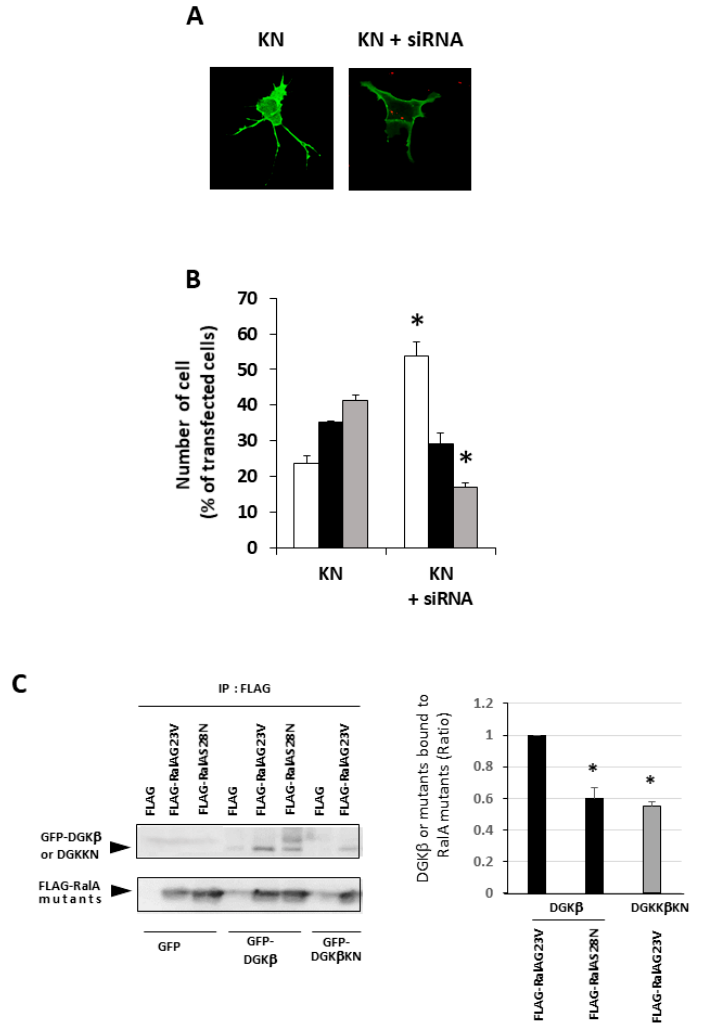
Figure 4. Importance of RalA in the DGK β KN-induced neurite outgrowth. ( A ) Typical image of SHSY-5Y overexpressing GFP-DGK β KN before and after treatment of siRNA for RalA. ( B ) Effect of siRNA for RalA on the number of cells having no (white column), one or two (black column) and several neurites (gray column). The plasmid of GFP-DGK β KN was transfected with or without 100 nM siRNA for RalA. More than 100 cells were observed in each experiment and three independent experiments were performed. The mean and SEM of the number of the cells are shown as percentage to the transfected cells. * p < 0.05, followed by Student’s t -test (vs. the control expressing GFP-DGK β KN). ( C ) Active form of RalA bound to both DGK β or DGK β KN. Pull down assay was performed using COS-7 cells separately overexpressing FLAG-RalA mutants and GFP-DGK β or GFP-DGK β KN. Three independent experiments were performed. The mean and SEM of density of bands are shown as ratio to the WT DGK β . * p < 0.05 followed by Student’s t -test (vs. GFP-DGK β ). It is well known that RalA binds to many proteins, including PLD and calmodulin [15]. We hypothesized that PLD is also involved in DGK β KN-induced neurite outgrowth because PLD and DGK β produce PA, which contributes to neurite outgrowth [16] and